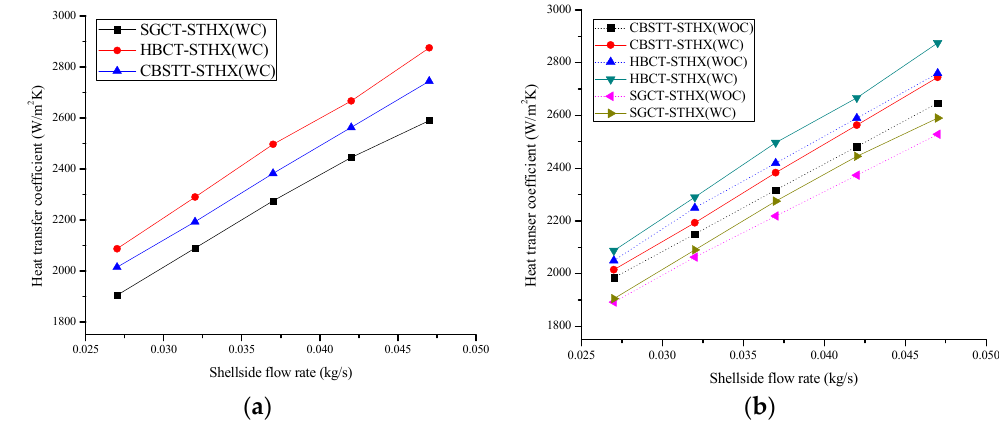
Figure 9. Heat transfer: ( a ) Shell side heat transfer coefficient versus mass flow rate and ( b ) heat transfer coefficient comparison of three STHXs, with and without tube-to-baffle-hole clearance.